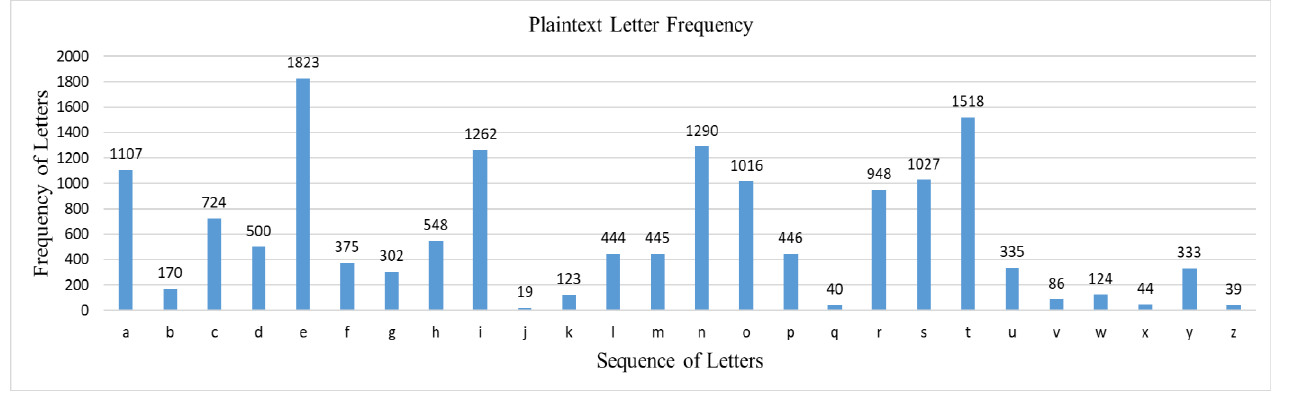
Figure 8 . Plaintext Letter Frequency Histogram